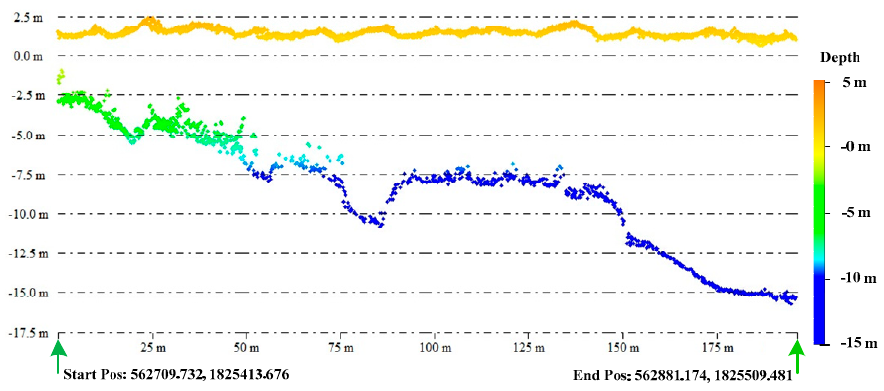
Figure 9. Depth map of profile.